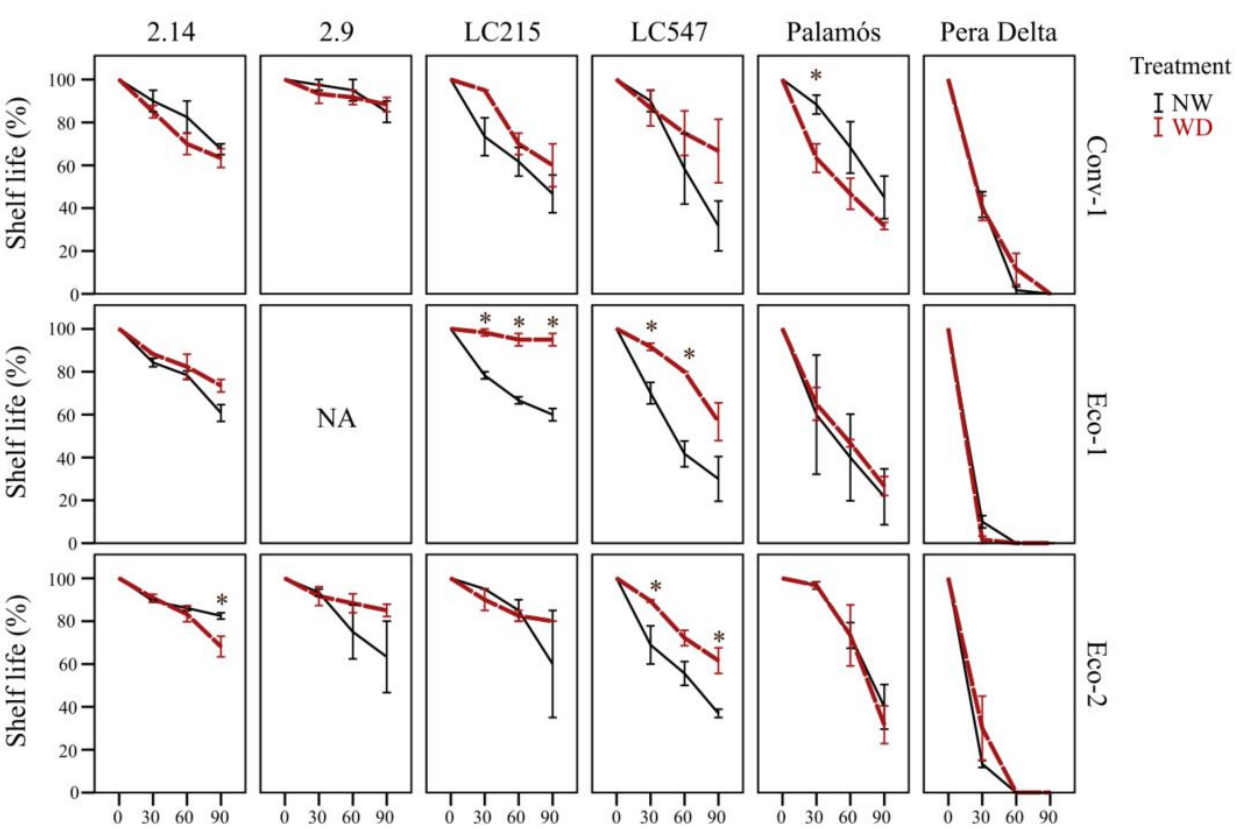
Figure 3. Effect of irrigation (NW, normal watering; WD, water deficit) on 90-day postharvest shelf life (percentage of sound fruits) of LSL genotypes grown in 3 localities (Conv-1, Eco-1, Eco-2). Stor- age in laboratory conditions (24 ± 2 °C; 62 ± 11% relative humidity). Error bars represent the SEM calculated on the basis of the 3 biological replicates. Significant differences between watering re- gimes are presented by an * ( p < 0.05). Genotypes: 2.9 and 2.14, Penjar breeding lines; LC215 (Penjar) and LC547 (Ramellet), LSL traditional lines; Palamós, Penjar modern hybrid; Pera Delta, processing variety. NA: not